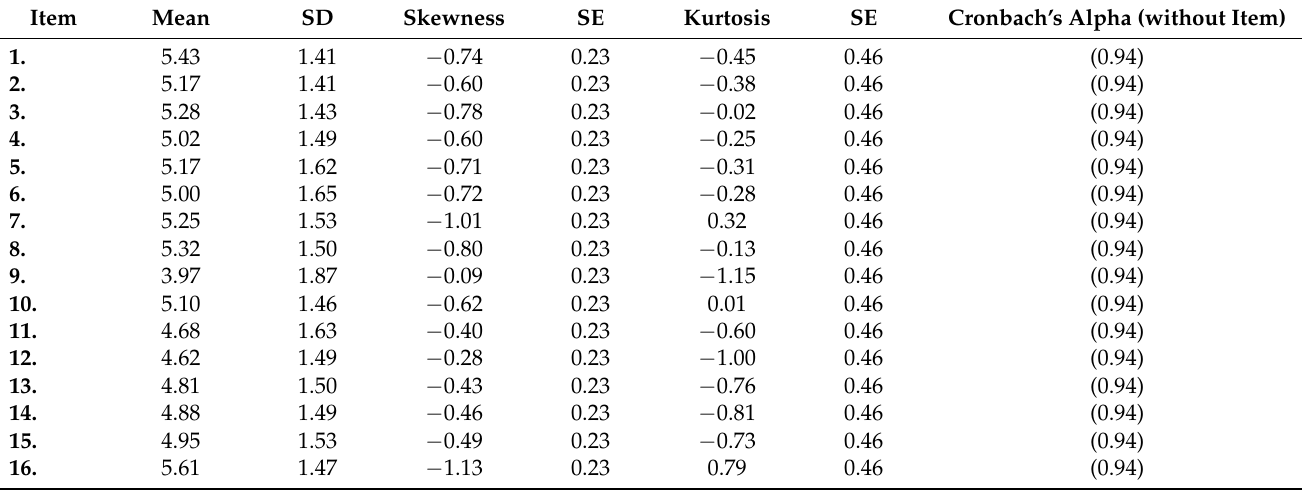
Table 2. Descriptive statistics, Cronbach’s alpha coefficient of RS, and EFA assessment of normality of